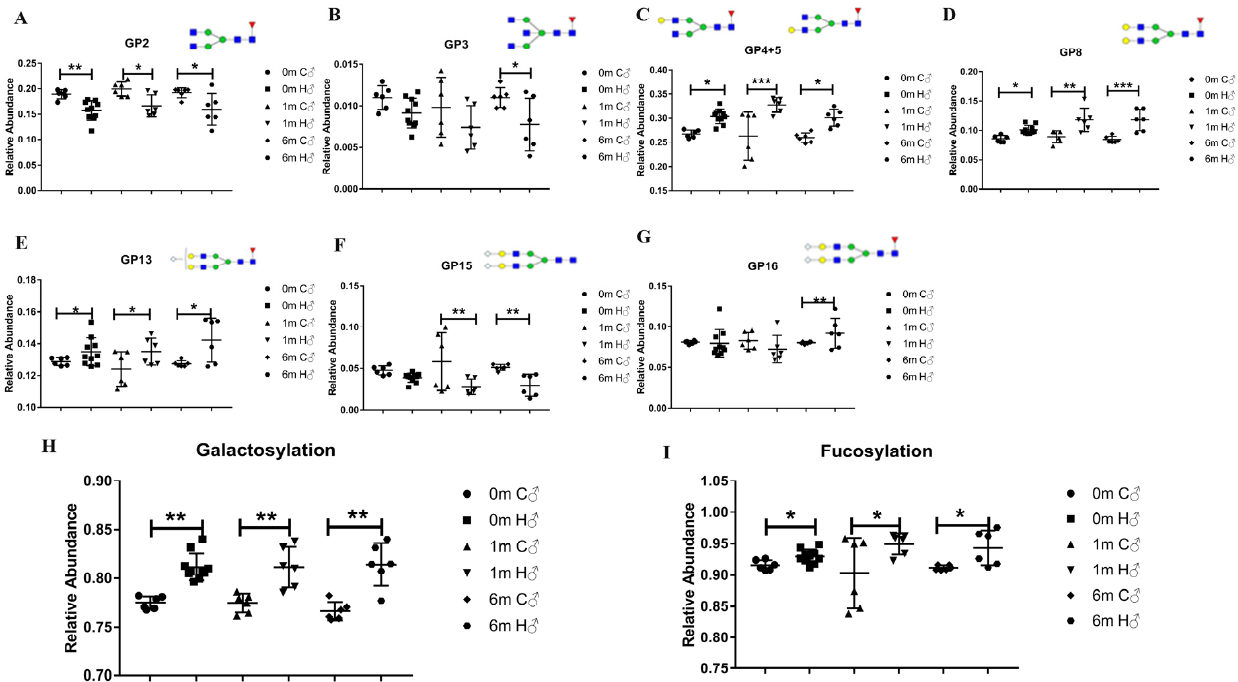
Figure 2. The changes in the serum IgG glycans between groups H and C at the three time points of 0, 1, and 6 months after administration during the cancer induction process in male mice, which indicated the relative abundance of galactosylation and that some IgG-N glycans are highly correlated with HCC. ( A ) GP2 in group H was lower than it was in group C at all three time points. ( B ) GP3 only decreased in group H at 6 months. ( C ) The sum of the relative abundances of GP4 and GP5 in group H was higher than it was in group C at all three time points. ( D ) GP8 in group H was higher than it was in group C at all three time points. ( E ) GP13 in group H was higher than in was in group C at all three time points. ( F ) GP15 decreased at 1 and 6 months. ( G ) GP16 only increased at 6 months. ( H ) Galactosylation in group H was higher than it was in group C at all three time points. ( I ) Fucosylation in group H was higher than it was in group C at all three time points. Structural symbols: blue square: N-acetylglucosamine; green circle: mannose; red triangle: fucose; yellow circle: galactose; white diamond: N-glycolylneuraminic acid. Data are expressed as mean ± SD. * p < 0.05, ** p <0.01, *** p <0.001. (C—control WT group; H—HCC WT group; 0 m/1 m/6 m—0 month/1 month/6 months after administration; ♂ —male mice). Table 1. The change trend of serum IgG glycan group H in male mice compared with group C at different time points in the process of cancer induction.